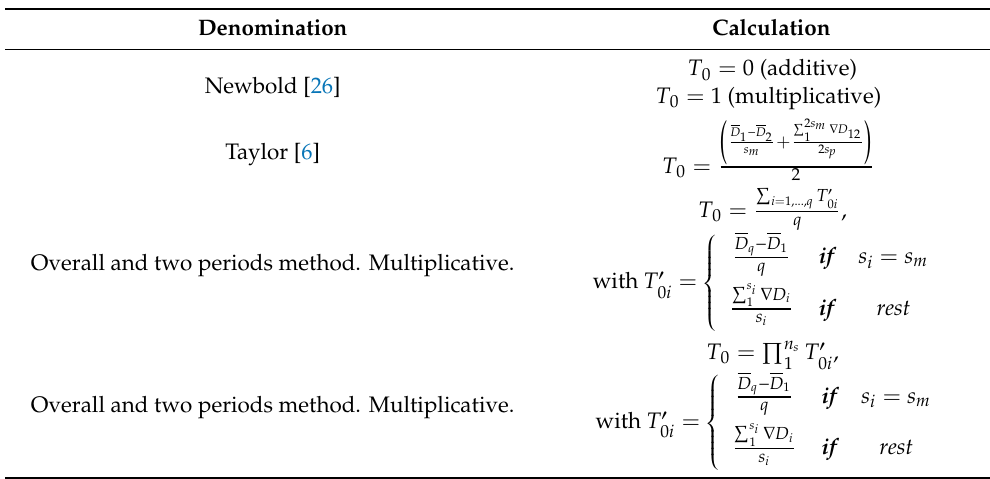
Denomination Calculation Newbold [26] Taylor [6]